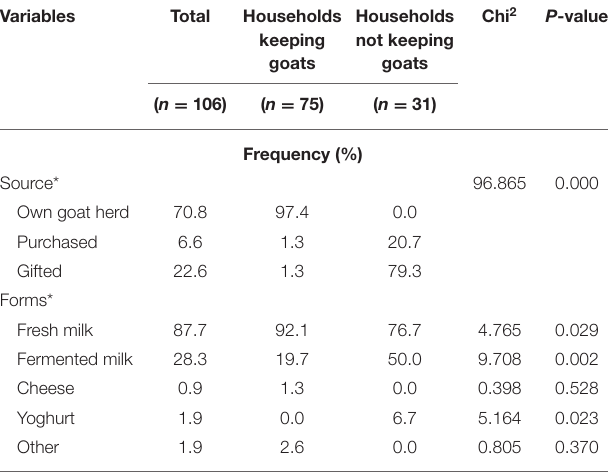
TABLE 2 | Origins and forms of consumed goat milk and milk products in Karimama, Niger Valley of Benin.